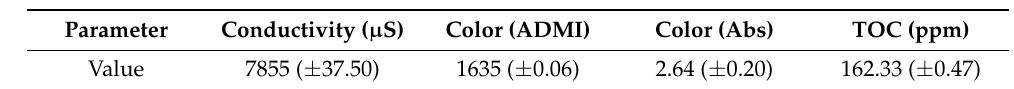
Table 1. Characteristics of the